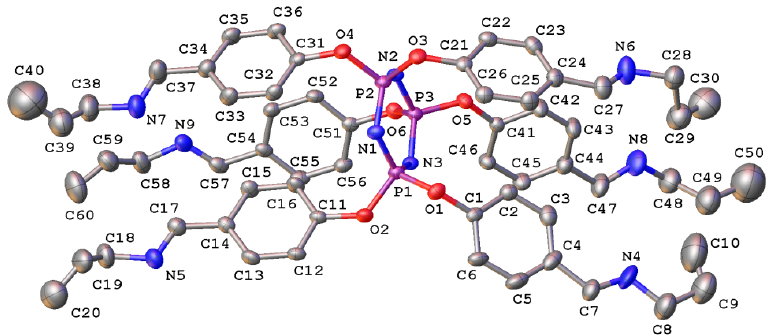
Figure 6. General view of the compound APP in the representation of non-hydrogen atoms as thermal ellipsoids at a 20% probability level. Hydrogen atoms as well as minor components of the disordered allyl groups are omitted for clarity.